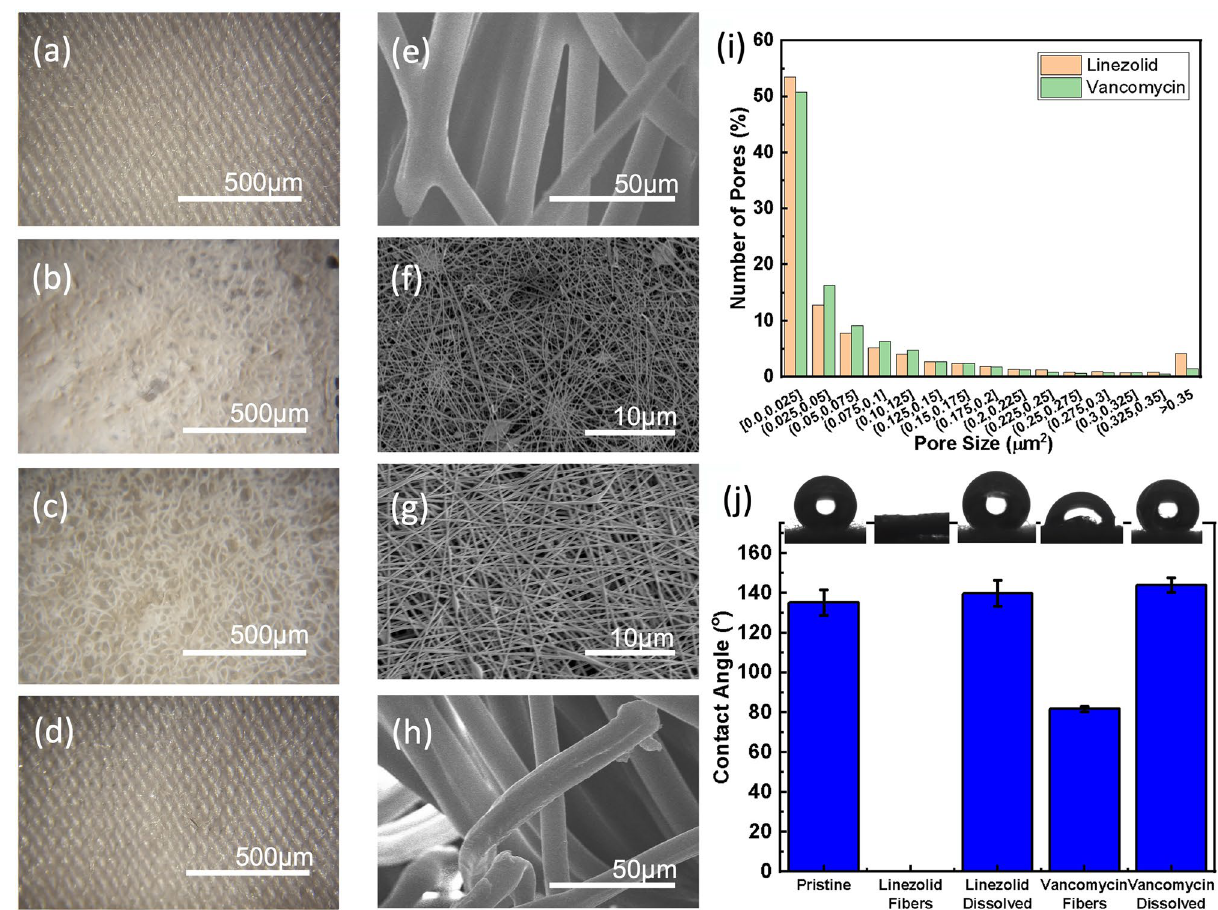
Figure 3. Properties of electrospun NF mat. Microscope image of ( a , e ) ozone delivery patch surface and ( b , f ) after coating with linezolid containing NFs, ( c , g ) and after coating with vancomycin containing NFs, ( d , h ) after the dissolution of the NFs. Images were taken using optical microscope ( a – d ) and SEM ( e – h ). ( i ) Histogram displaying frequency of pore size within vancomycin and linezolid spun fiber mats. ( j ) Contact angle measurement of dressing at various stages of treatment. Error bars denote standard